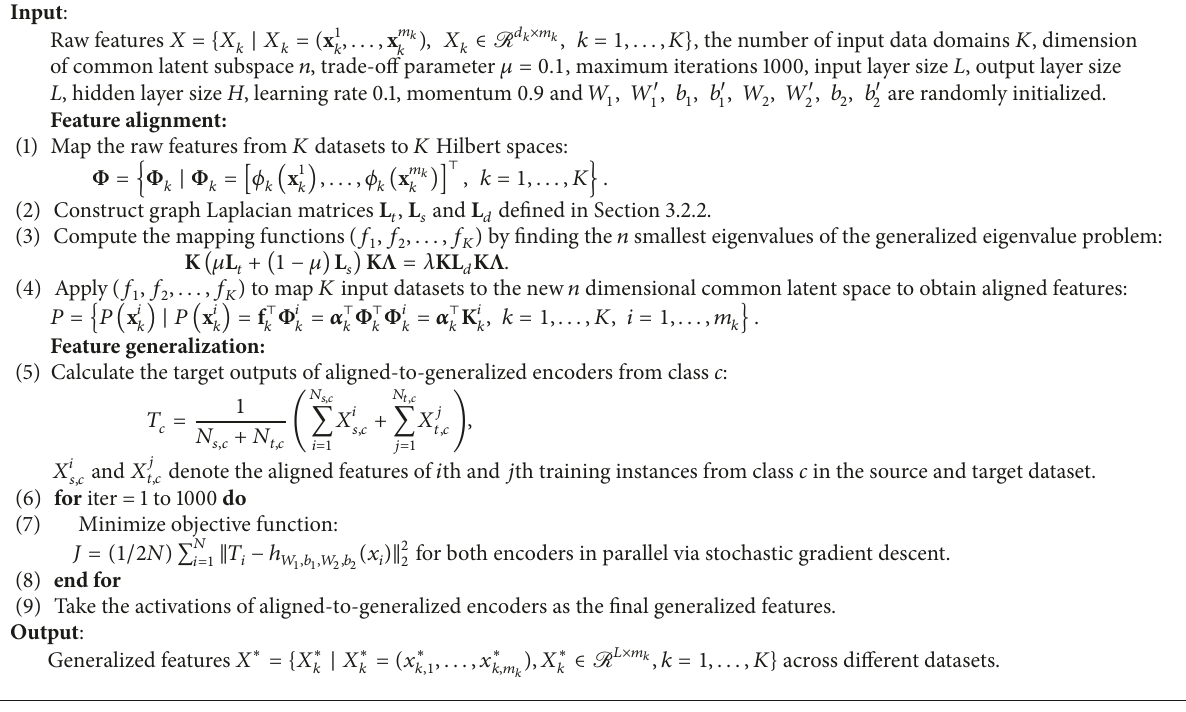
Algorithm 1: Framework of Cross-Dataset Feature Alignment and Generalization